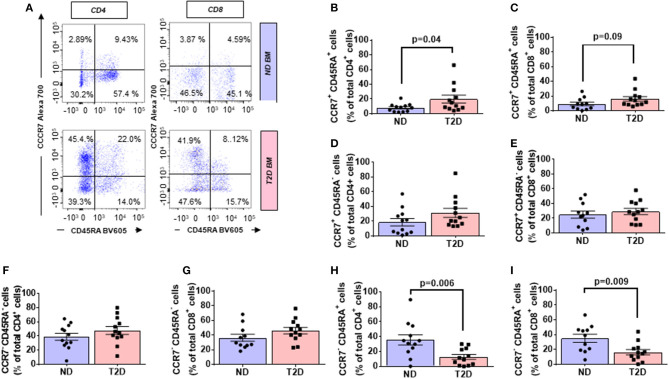
Increased relative abundance of CCR7 expressing T lymphocytes in BM of patients with T2D. (A) Gating strategy for identification of CCR7 and CD45RA. The numbers indicate the percentage of naïve T cells (CCR7+ CD45RA+, top right quadrant), central memory T cells (TCM, CCR7+ CD45RA−, top left quadrant), effector memory T cells (TEM, CCR7− CD45RA−, bottom left quadrant), and terminal effector T cells (TEMRA, CCR7− CD45RA+, bottom right quadrant) gated on the forward and side scatter of the lymphocyte populations. Reported frequencies are illustrative of a representative case for each group. (B–I) Bar graphs showing the relative frequency of CCR7+ CD45RA+ naive cells in CD4+
(B) CD8+ cells (C) CCR7+ CD45RA− TCM cells in CD4+
(D) and CD8+ cells (E), CCR7− CD45RA− TEM cells in CD4+
(F) and CD8+ cells (G) CCR7−CD45RA+ TEMRA cells in CD4+
(H) and CD8+ cells (I). Values are mean ± SEM, with each point representing an individual case.